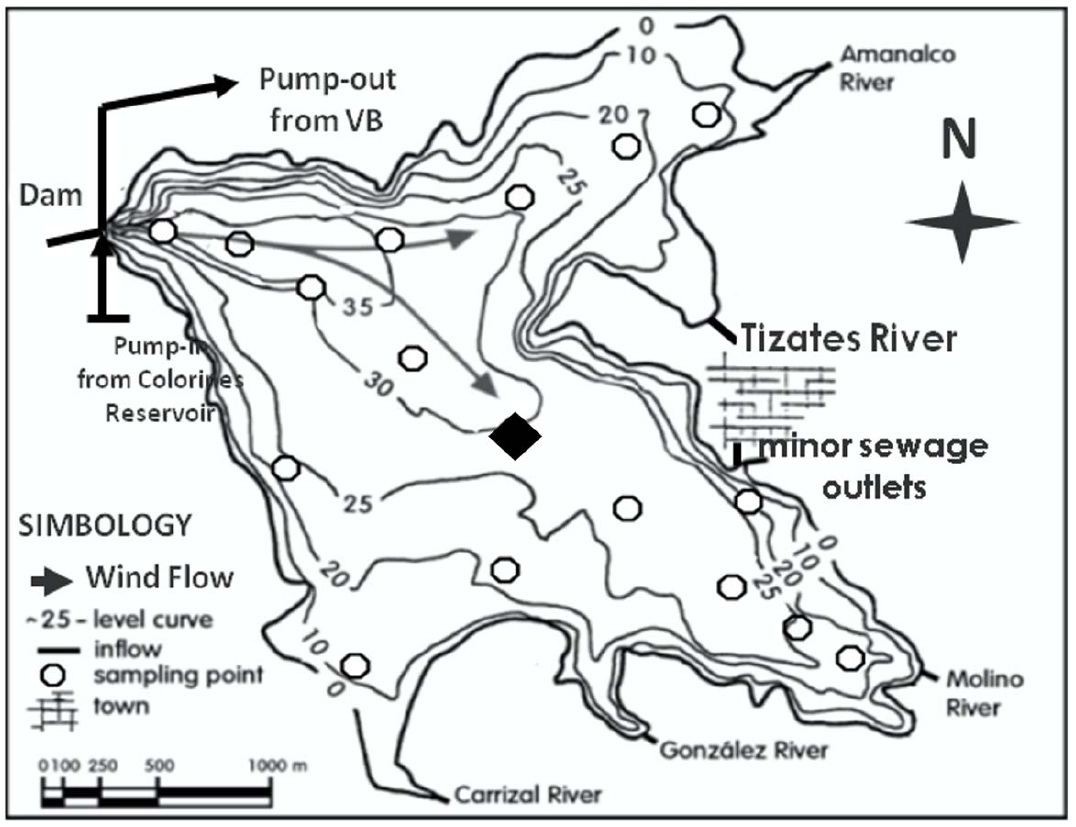
Figure 2. Bathymetric map of Valle de Bravo (VB) reservoir showing the main water inputs (rivers and sewages) and the water withdrawal through pump-out at the dam. Circles indicate all the eventually sampled sites and the black diamond indicates the central station sampled throughout the long-term period here reported. Depth contours are reported in meters below the maximum level of the lake. The arrows indicate the diurnal wind pathways along both arms of the lake. Modeled after Merino-Ibarra et al. (2021).